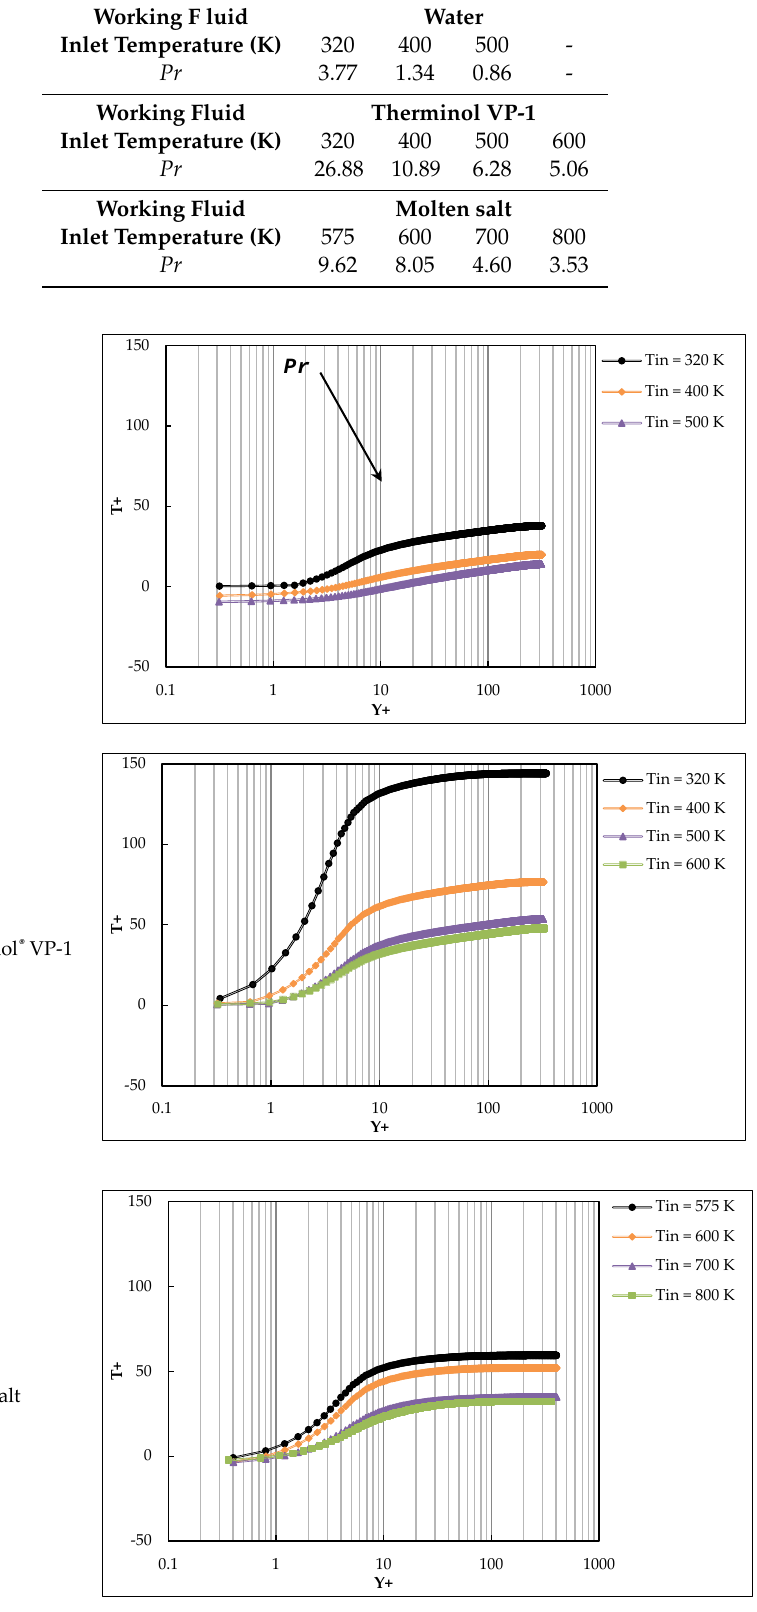
Figure 14. Temperature profiles of all working fluids used in the current study.